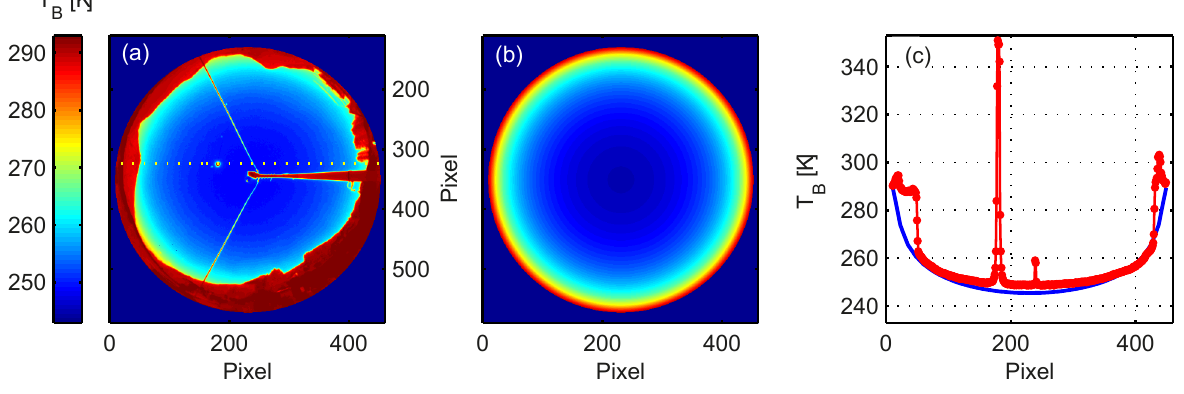
Figure 4. (a) Measured brightness temperature ( T B ) on the cloud-free day 18 June 2017, 10:49UTC (SZA = 24 ◦ ), (b) the corresponding modelled brightness temperature and (c) the measured (red) and modelled (blue) profile of the sky brightness temperature along one azimuth position (shown as a yellow line in a